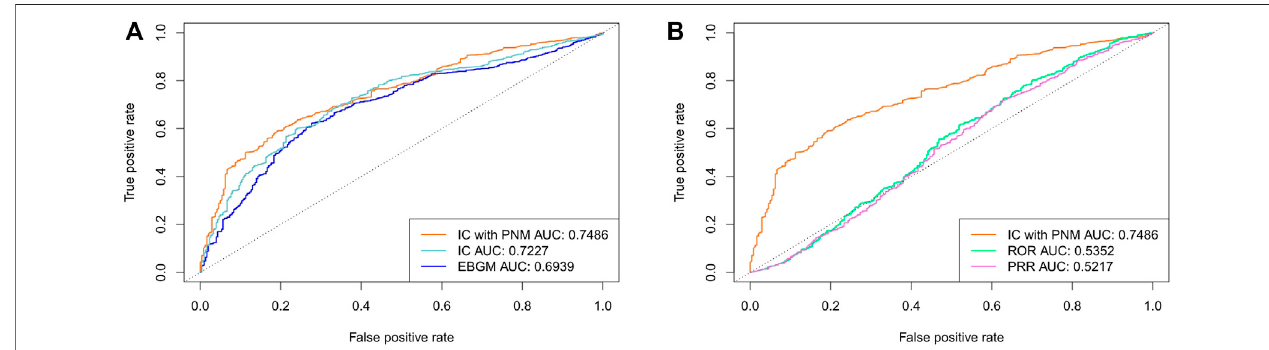
FIGURE5|(A) Comparison ofperformancesofIC PNM ,IC, andEBGMusing crossvalidation basedon theFAERS2014-2019Q2 data andSIDER (B) Comparison of performances of IC PNM , ROR, and PRR using cross validation based on the FAERS 2014-2019Q2 data and SIDER.